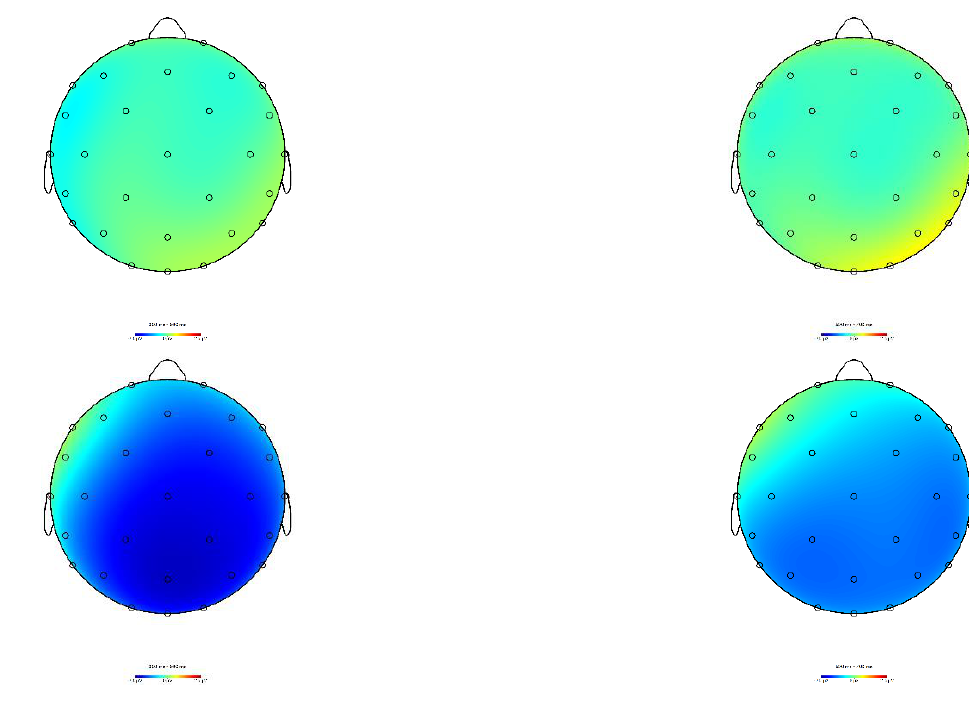
Figure 6. Scalp maps of relatedness effects (voltage differences were computed by subtracting the related from the unrelated condition) averaged across the N400 and the LPC time windows in Experiment 2 (upper row, the form condition and lower row, the semantic condition). Scale from − 2.5 μ V (blue) to 2.5 μ V (red).